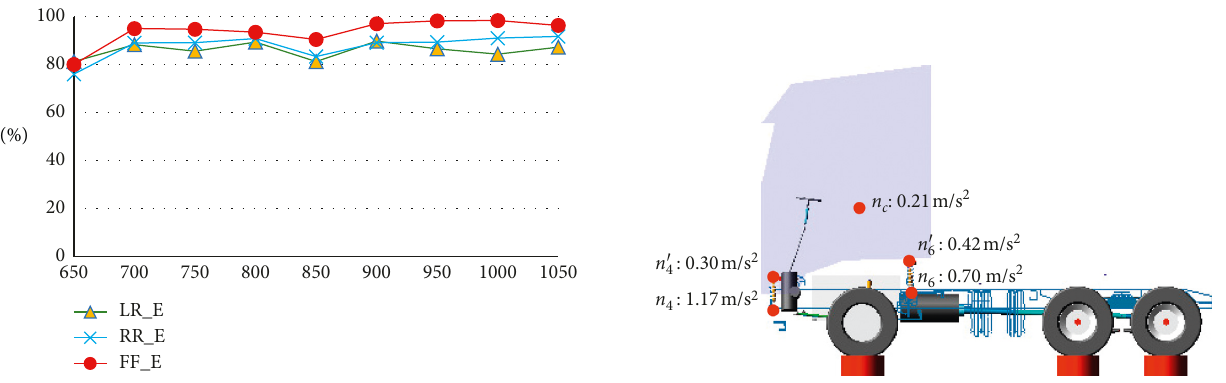
Figure 14: RMS value of the measuring point on the cab mounting